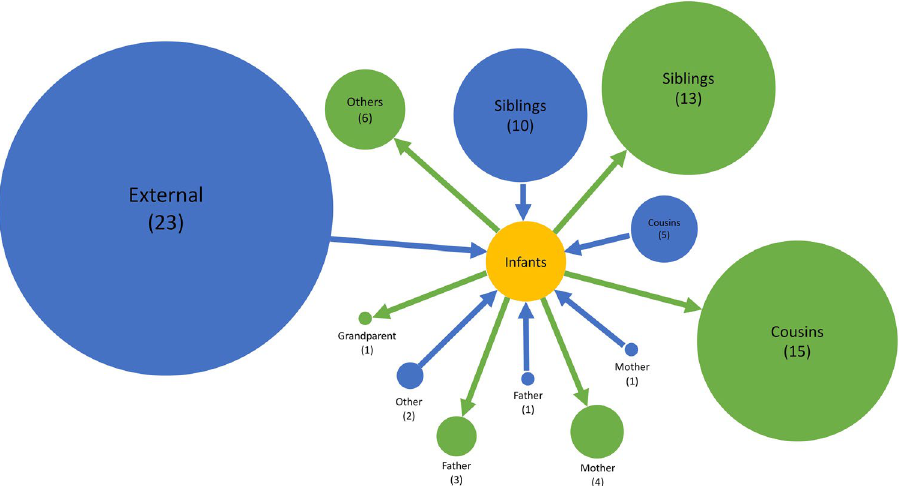
Figure 4. Network showing the sources of infection to the infant and who the infants infected as identified by social relationship. The blue circles show the sources to infant infection while the green show who the infants infected. The size of the circles is proportional to the number of cases which is given in